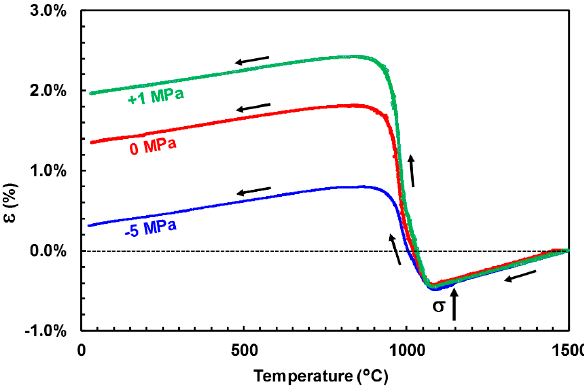
Figure 5. Constrained thermal expansion curve of the ZrO 2 -SiO 2 refractory upon cooling, calculated assuming the strain-free state to hold at the maximum temperature (1500 °C). The stress was applied just before the start of the phase transformation (see vertical arrow).